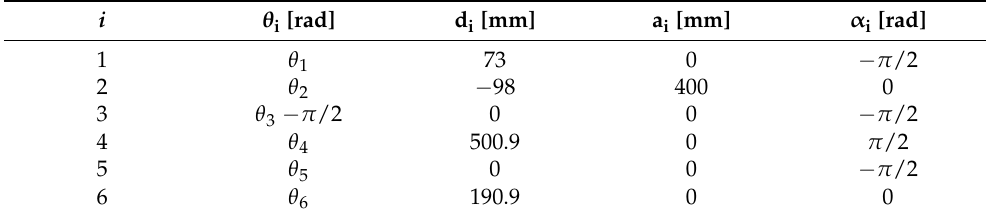
Table A1. Denavit–Hartenberg parameters.